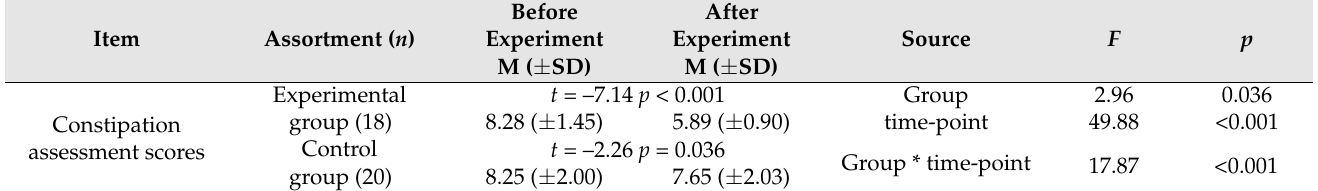
Table 5. Test for Differences Between Groups for Constipation Assessment Scores ( n =